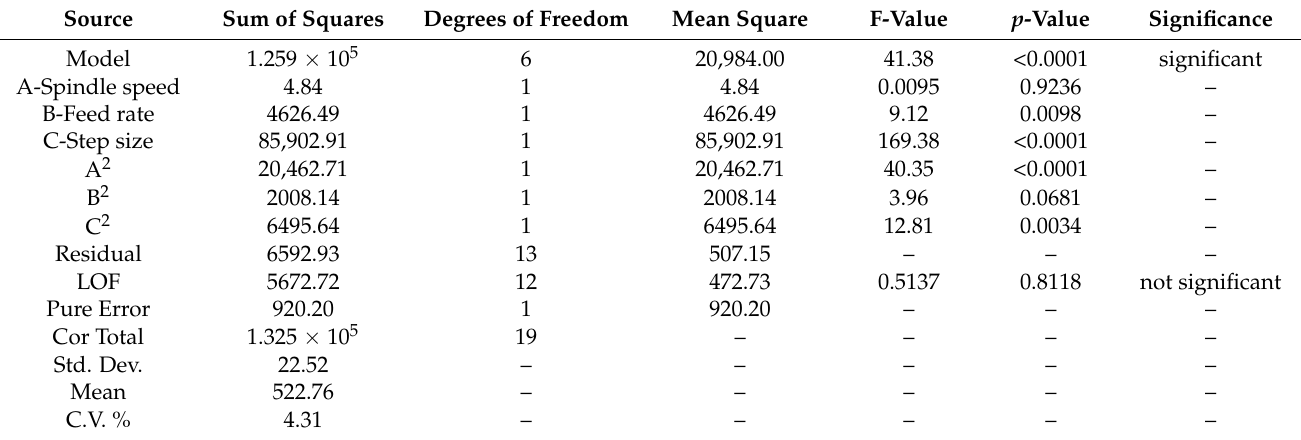
Table 5. ANOVA results of the axial force in